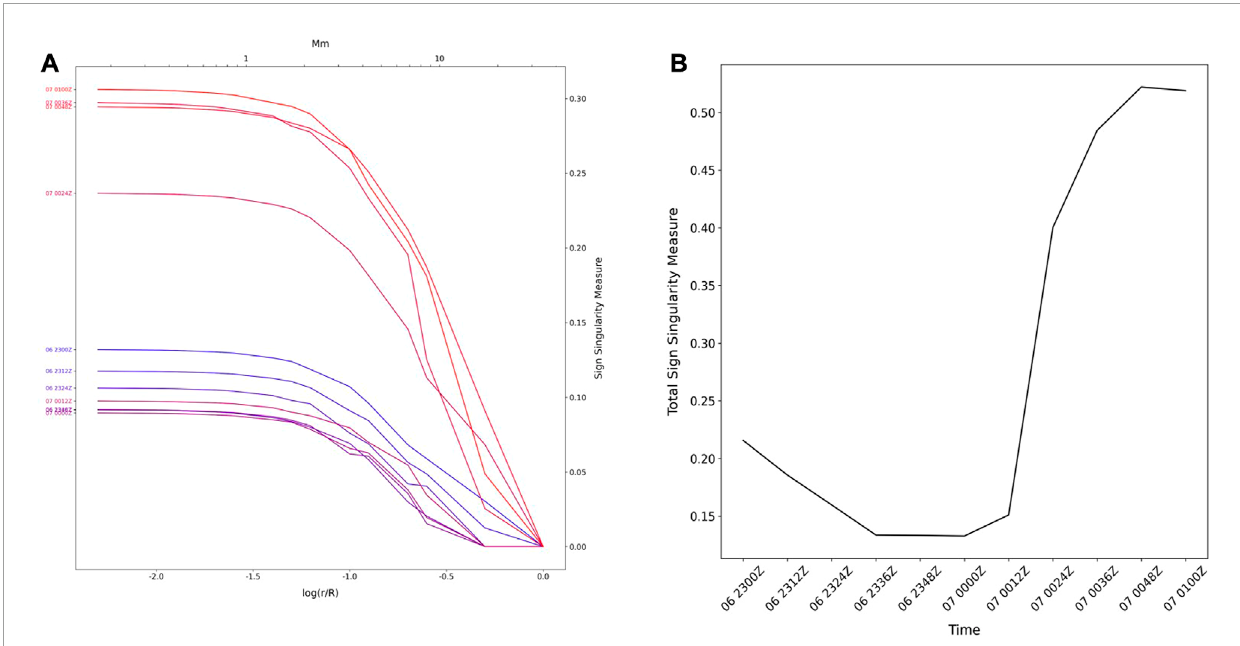
FIGURE 11 (A) Sign-singularity measure curves calculated from the vertical twist maps shown in Figure 10 and (B) the time series of the total sign-singularity measure (calculated as the area under the curves).